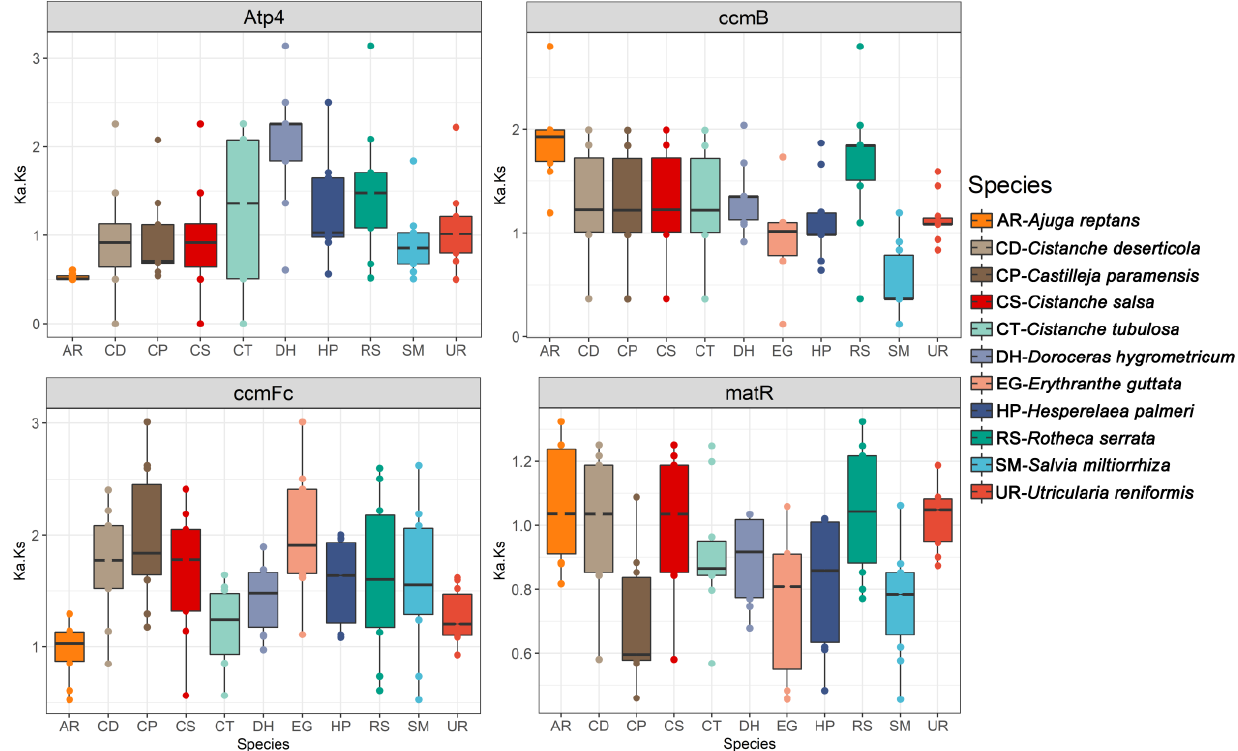
Figure 5. Boxplots of pairwise Ka/Ks values among each retained mitochondrial protein-coding gene within the 11 Lamiales species.